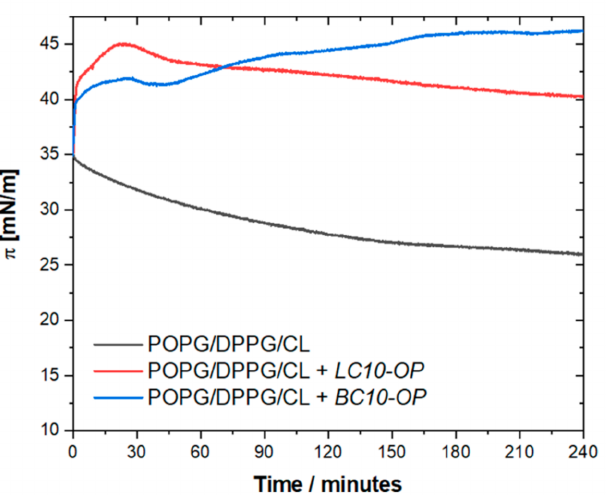
Figure 2. Changes in surface pressure as a function of time recorded for DPPG/POPG/CL monolayer compressed to initial surface pressure of 35 mN/m (black curve) and DPPG/POPG/CL monolayers compressed to initial surface pressure of 35 mN/m after injection of LC10-OP (red curve) and BC10-OP (blue curve) into the subphase. An aqueous solution of 0.01 M PBS was used as a